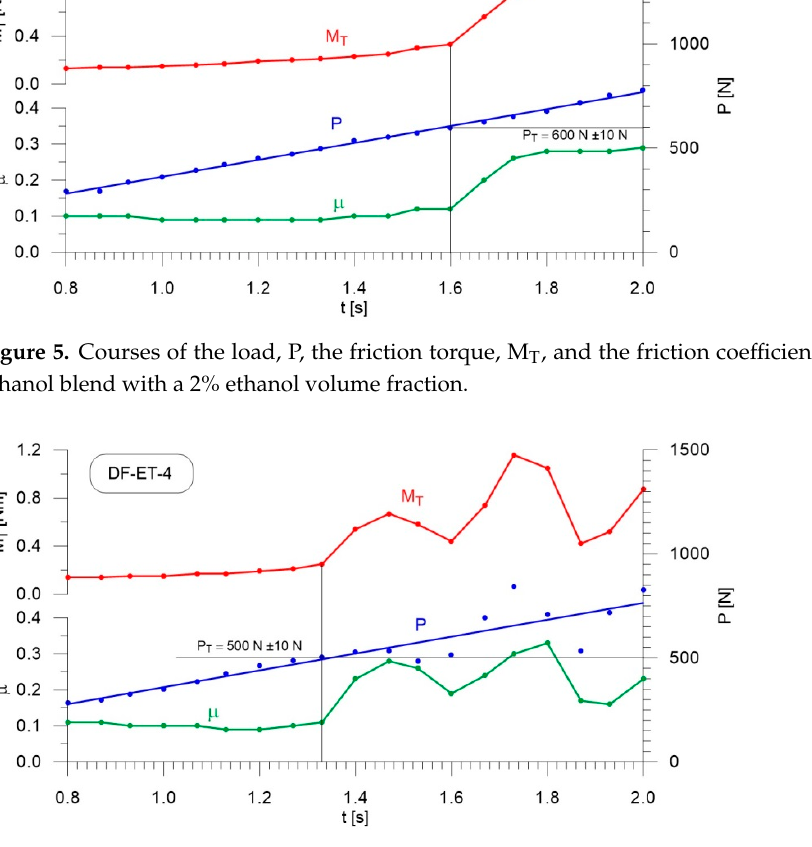
Figure 7. Courses of the load, P, the friction torque, M T , and the friction coefficient, µ, for diesel– ethanol blend with a 6% ethanol volume fraction.